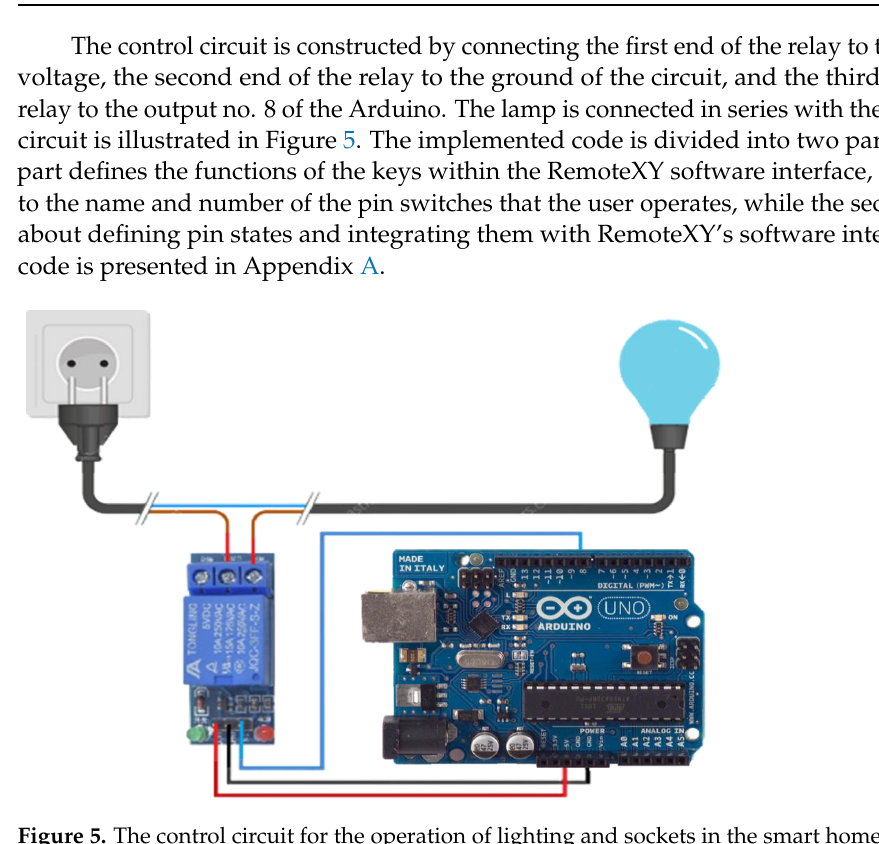
Table 3. The main components used to control the fan